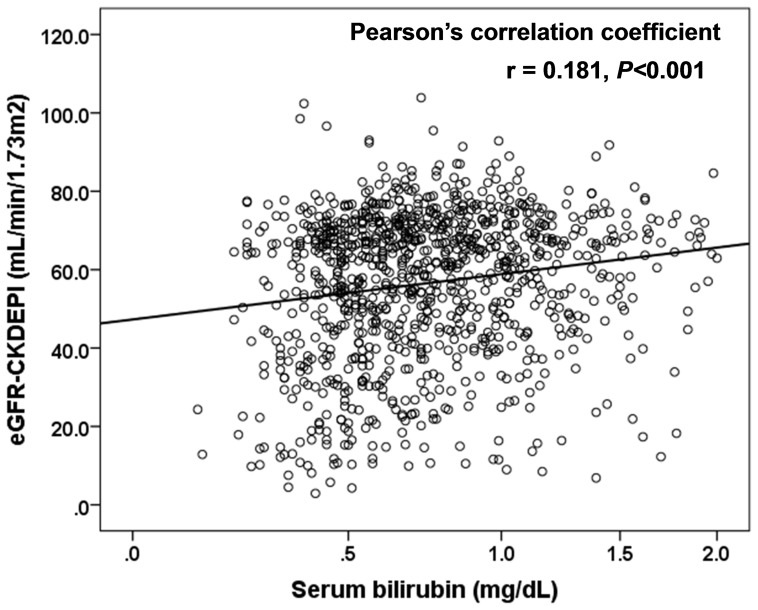
Relationship between serum bilirubin and estimated glomerular filtration rate (eGFR).eGFR was calculated using CKD-EPI equations modified by a Japanese coefficient (eGFRCKDEPI): Male, Cr ≤0.9 mg/dl, 141× (Cr/0.9) −0.411 ×0.993 age ×0.813; Cr>0.9 mg/dl, 141× (Cr/0.9) −1.209 ×0.993 age ×0.813; Female, Cr ≤0.7 mg/dl, 144× (Cr/0.7) −0.329 ×0.993 age ×0.813; Cr>0.7 mg/dl, 144× (Cr/0.7) −1.209 ×0.993 age ×0.813. Serum bilirubin was skewed and log-transformed for analysis.